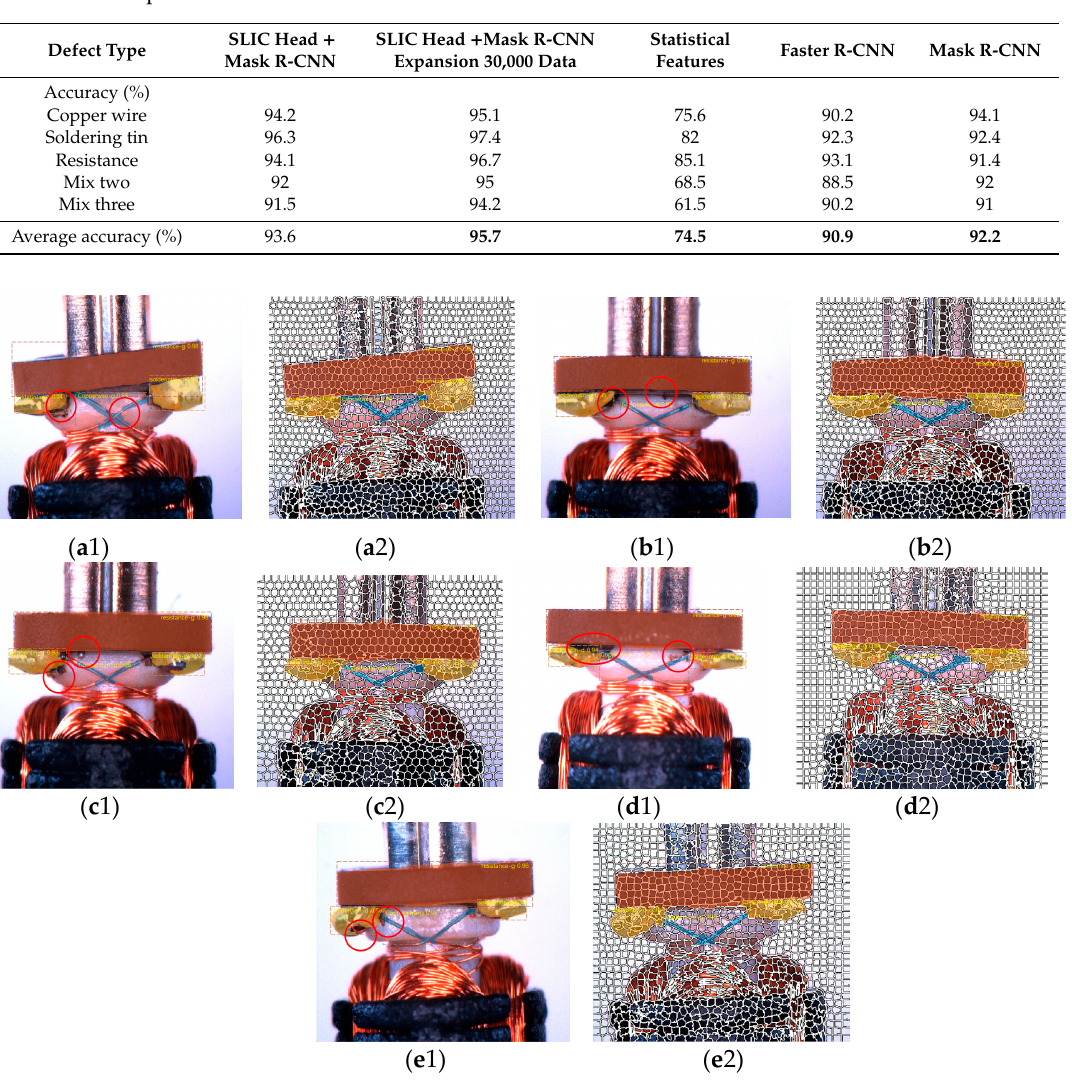
Table 1. We compared the accuracy of models with different sizes of superpixel cell ( a ) and with different overlap areas of superpixel cell ( b ).